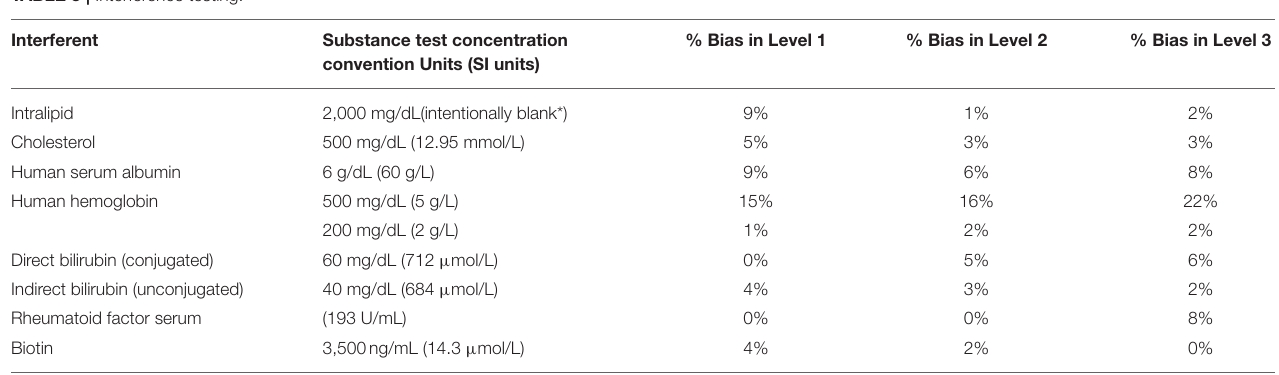
TABLE 3 | Interference testing.